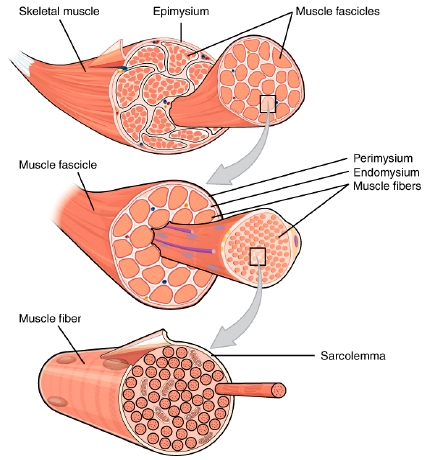
Figure 1. The hierarchical structure of the skeletal muscle. Reproduced from [19], Creative Commons Attribution License. Attribution